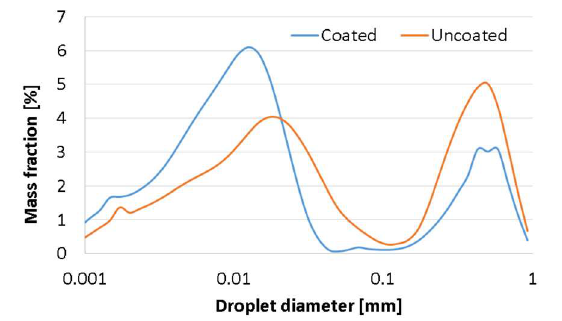
Fig. 3. The droplet size distribution